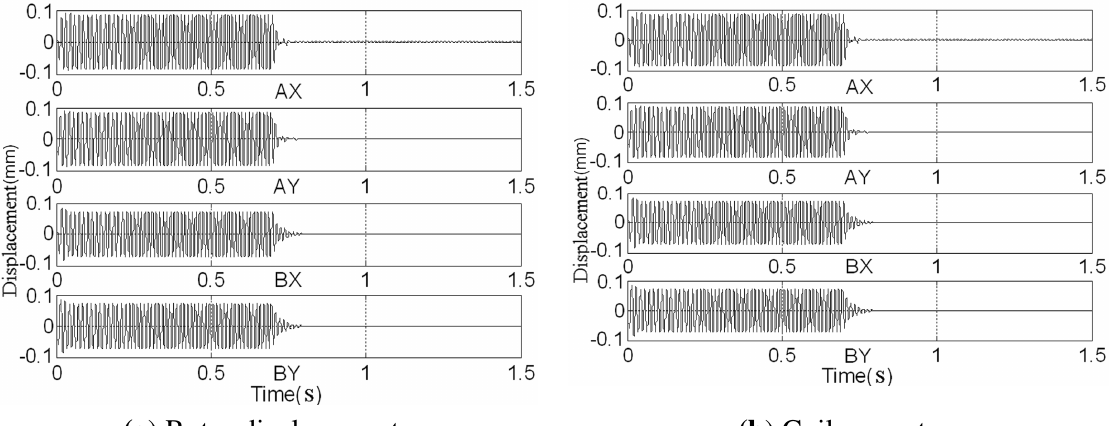
(a ) Rotor displacement. (b ) Coil